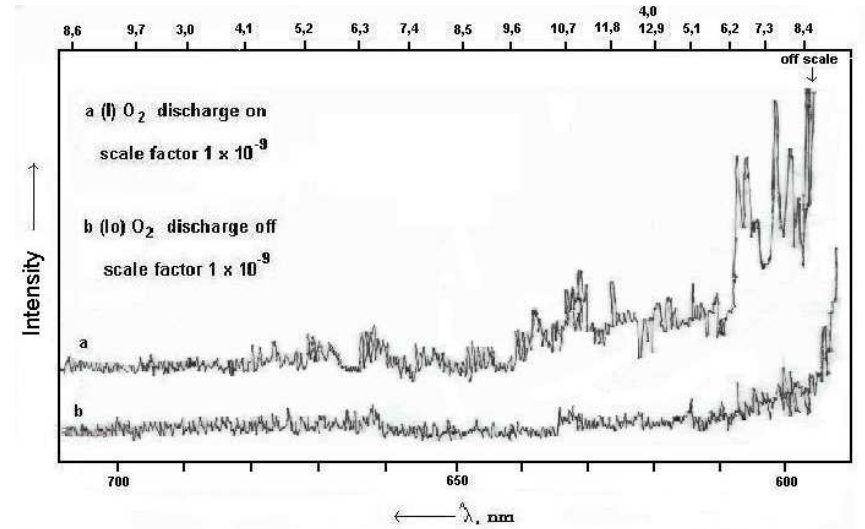
Fig. 3 N 2 (B 3 Π g → A 3 Σ + ) emission spectra showing parts of the ∆ υ = 3 and 4 band sequences u of the first positive band system (1pbs), with and without discharged O 2 . The vibrational levels of each band in a 1pbs { N 2 (B 3 Πg → A 3 Σu + ) } sequence are shown over each band with the N 2 (B 3 Πg) vibrational level of each band shown first. Active nitrogen was produced by reacting N 2 with discharged A r . P N = 1.9 mbar, P A = 1.3 mbar and P O = 0.3 mbar. The spectra are 2 2 r not corrected for grating and detector nonuniform spectral response.